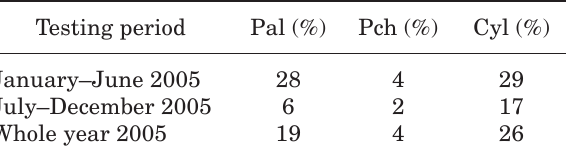
Table 1. Percent incidence of infected vines in randomly selected, non-symptomatic grapevines in California nurs- eries. A total of 165 rooted grapevine cuttings from var- ious nurseries was tested by PCR for P. aleophilum (Pal), P. chlamydospora (Pch) and Cylindrocarpon spp. (Cyl). Testing period Pal (%) Pch